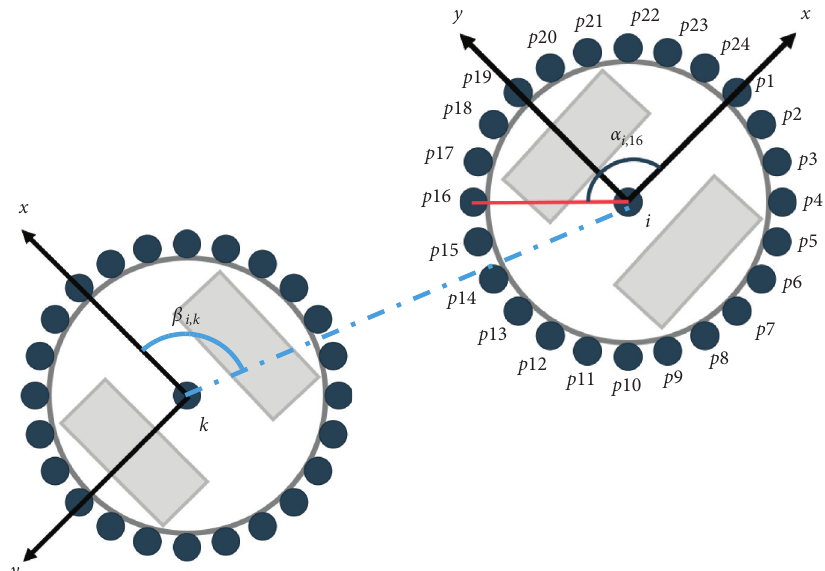
Figure 3: The kinematic model of the robots. The x direction identifies the front of the robot, p angle of the j th proximity sensor, and β i,k is the angle between the i th robot and the k th robot.